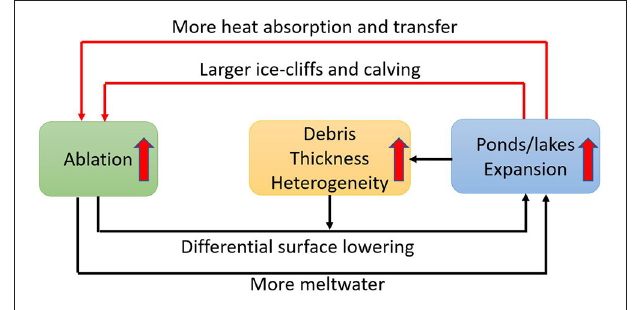
FIGURE 10 | Conceptual diagram that illustrates the positive feedbacks between ablation, surface ponding and the spatial distribution of debris